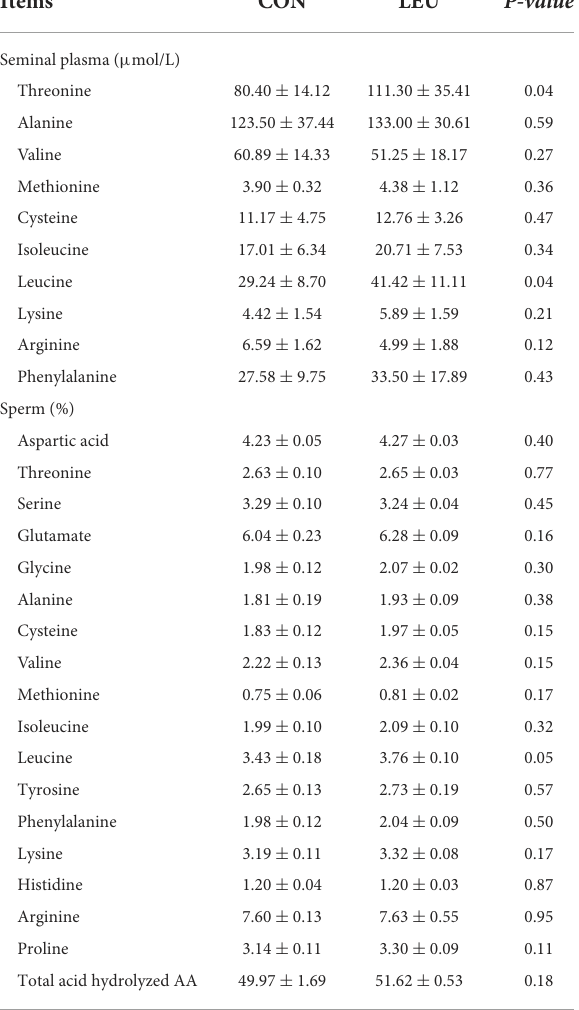
TABLE 9 Effect of leucine supplementation on FAA in boar seminal plasma ( µ mol/L) and AA of boar sperm (%).